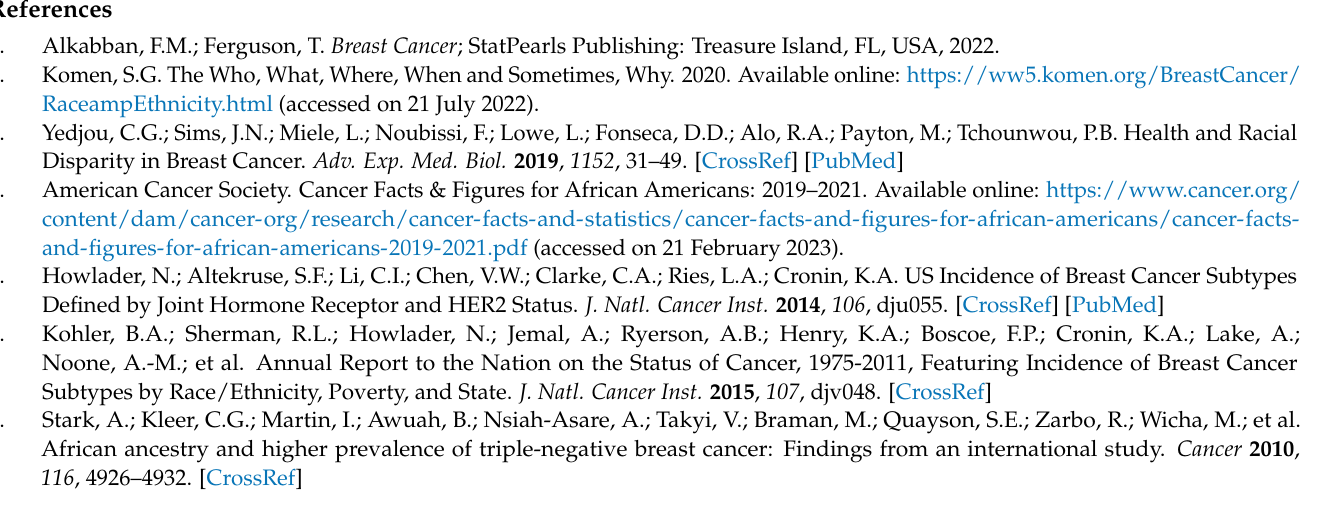
Figure A11. Percent Black vs. Percent White Population, MQSA-Certified Mammography Clinics, and Income by ZIP Code Tabulation Area in Oakland, CA.